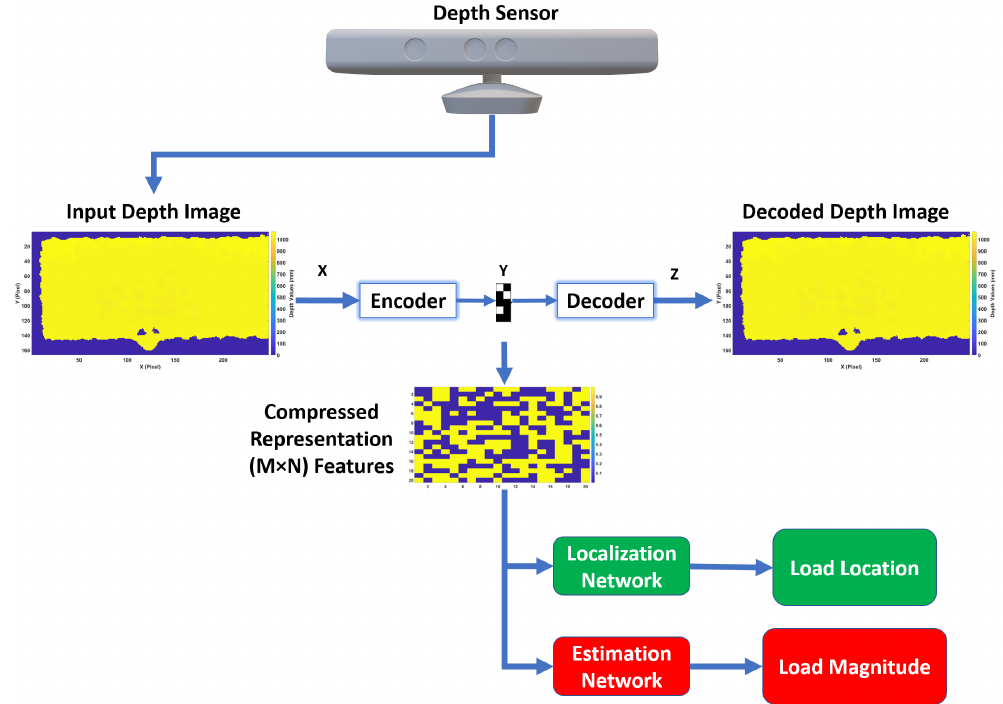
Figure 1. Proposed realtime load localization and estimation framework for SHM.